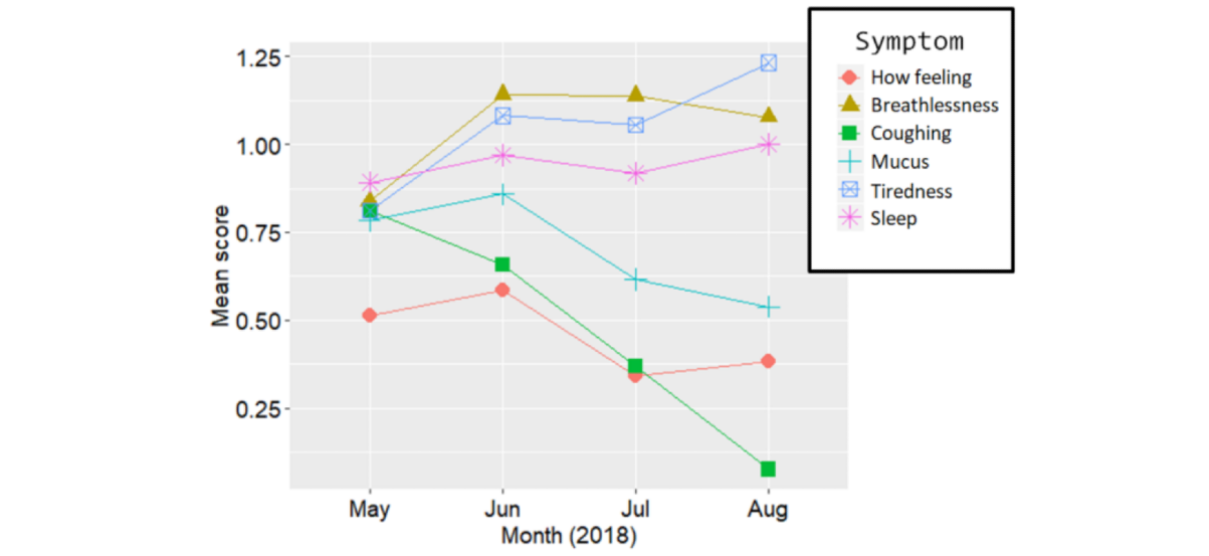
Figure 7. Average score for all participants (N=37) per month for the impact of symptoms. Note that "how feeling" is rated on a 3-point scale (0=great, 1=so-so, and 3=bad), and the other symptoms are rated on a 4-point scale (0=none, 1=mild, 2=moderate, and